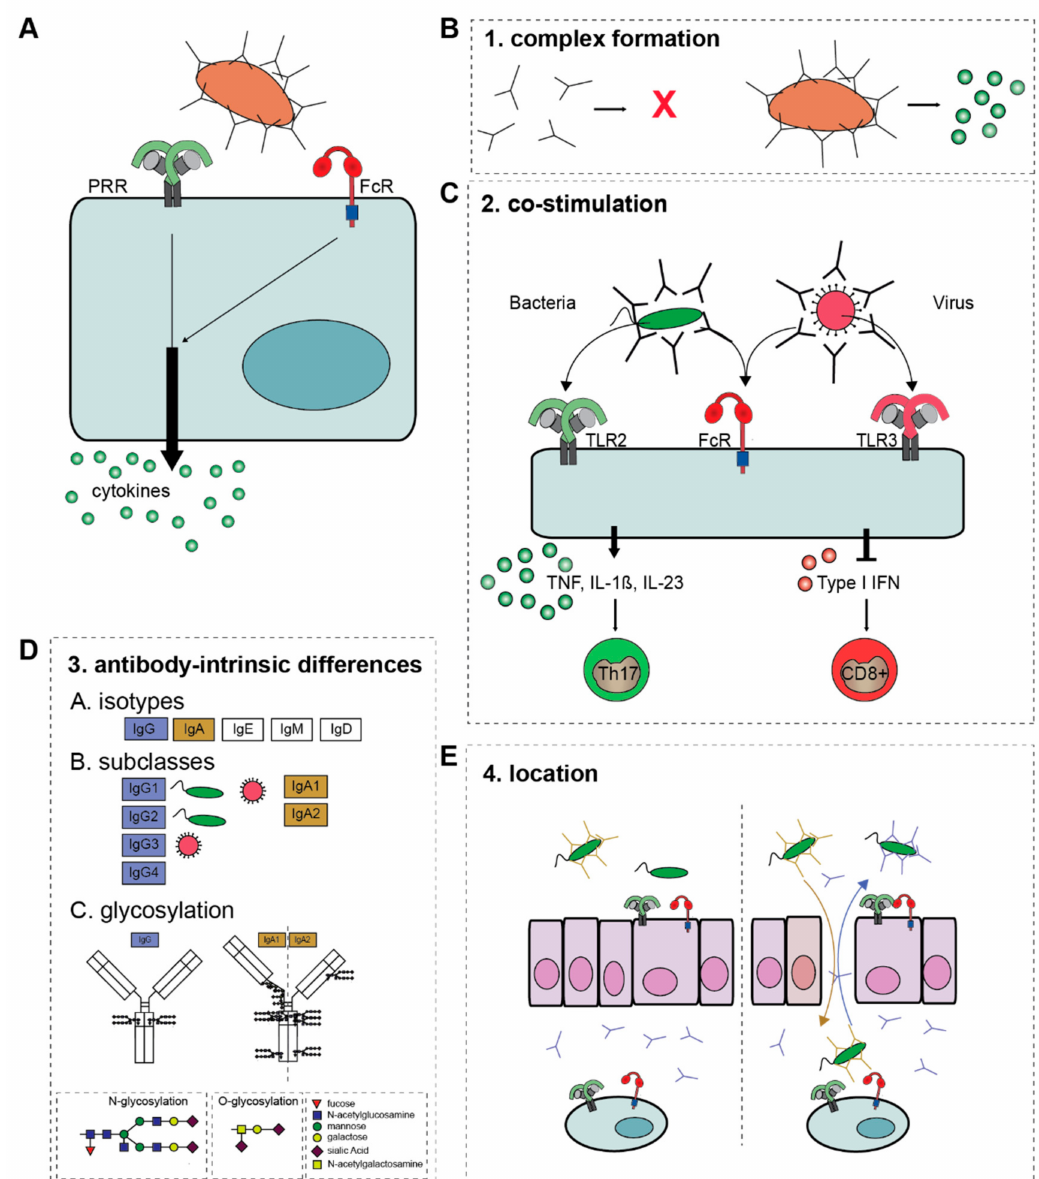
Figure 2. The four criteria of ADI activation. ( A ) FcR-PRR cross-talk modulates PRR-induced cytokine production. The overall outcome of ADI depends on four criteria. ( B ) 1. Antibody-complex formation, ( C ) 2. The co-stimulus that FcRs collaborate with, which determines the ultimate cytokine profile. ( D ) 3. The composition of the Fc tail of the antibody, i.e., A; isotype, B; subclass, and C; glycosylation. ( E ) 4. The location and (local) concentration of antibody immune complexes. Natural barriers, such as epithelial cells mediate tolerance to bacteria, which is disrupted when epithelial layers are damaged, and IgG translocates to the lumen, while IgA translocates to the lamina propria. Abbreviations: TNF, tumor necrosis factor; IL, interleukin; TLR, Toll-like receptor; ADI, antibody-dependent inflammation; PRR, pattern recognition